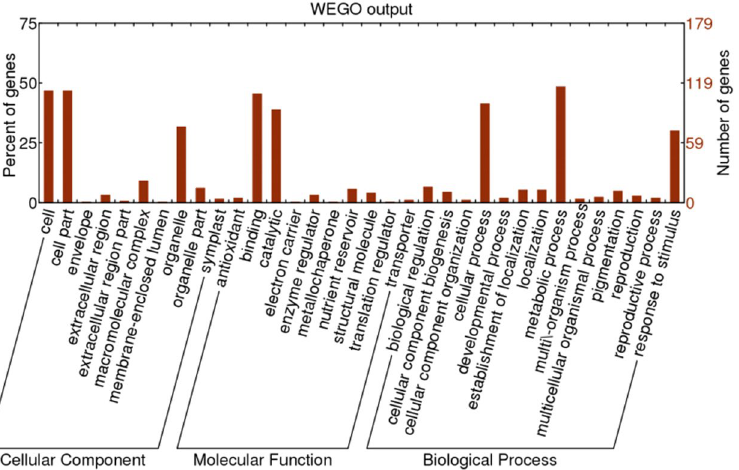
Figure 1. GO annotation terms of differentially expressed proteins at GO level 2 in wheat cultivar